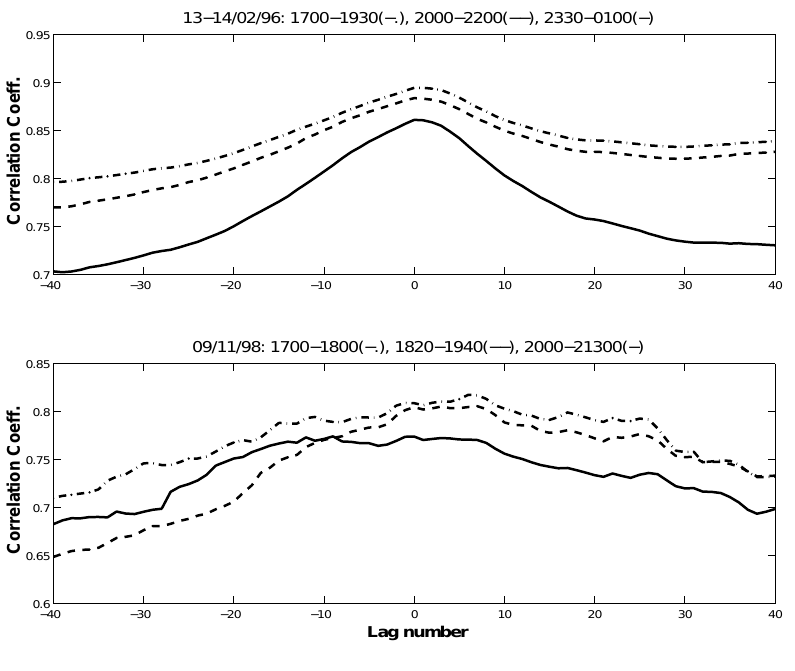
20:00–21:30UT). The unit time-lag is 10s, the lowest common time resolu- tion for IRIS and DASI. Positive lags mean that the absorption maximum pre- cedes the green-line